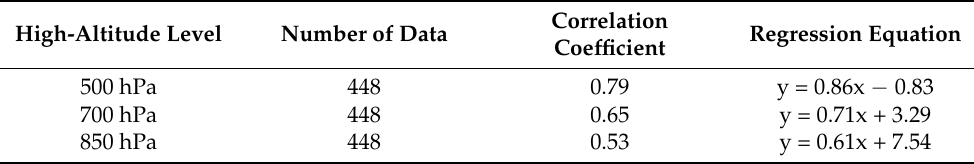
Figure 2. AIRS and sounding scatter plots of 850, 700, 500 hPa from top to bottom for ( a ) temperature and ( b ) dew point. Table 2. Temperature correlation coefficients and linear regression equations for each level of 00Z for July and August of